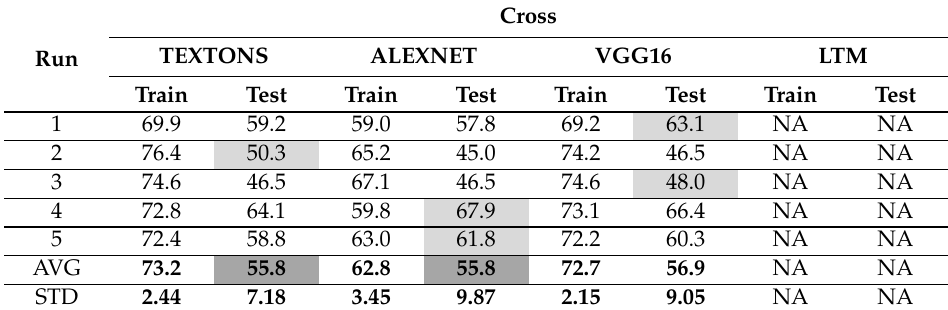
Table 5. Results of classification (% correct) with predictor sets derived from the cross recurrence combination of mill temperature and power data and use of a cubic kernel support vector